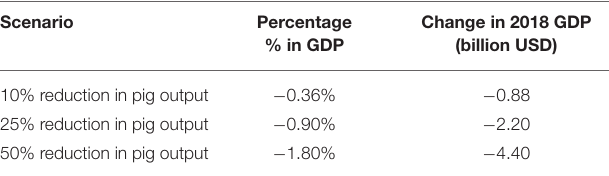
TABLE 3 | Impacts on GDP induced by a reduction in the value of pig output caused by ASF under different scenarios.